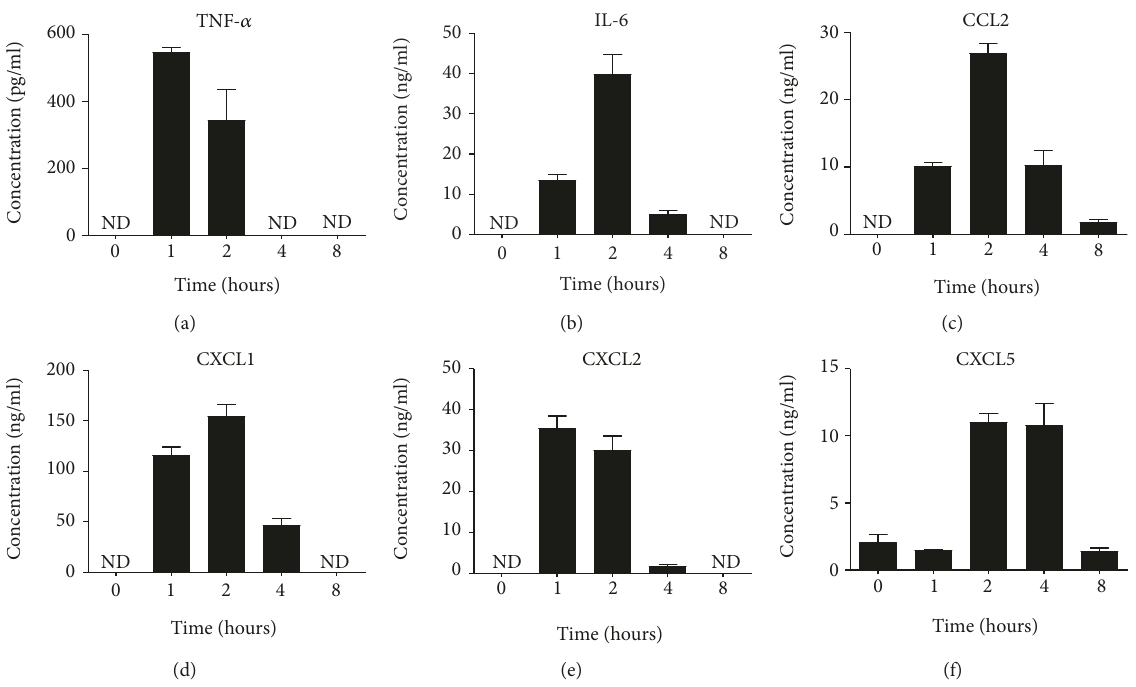
Figure 2: Proin fl ammatory mediator levels peak at 2 hours post LPS challenge. Male C57BL/6J mice (8 – 10 weeks old) were administered i.p. with 1 mg/kg LPS and the levels of proin fl ammatory mediators in the serum was measured up to 8 hours post challenge. The levels of TNF- α (a), IL-6 (b), CCL2 (c), CXCL1 (d), CXCL2 (e), and CXCL5 (f) were measured in the serum by ELISA. Data are from one experiment with 5-6 mice per time point. Mean +SEM are represented in all bar graphs. ND: not